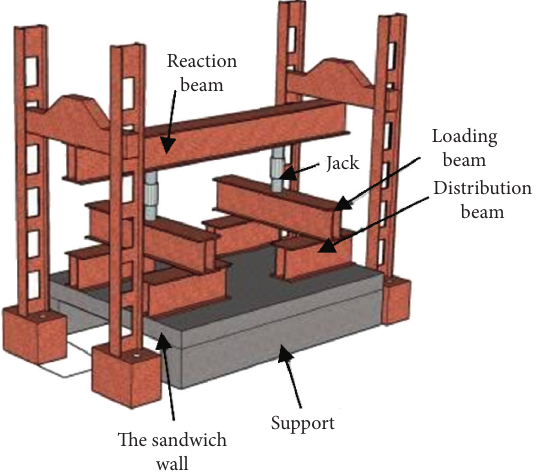
Figure 2: The loading device for bending performance